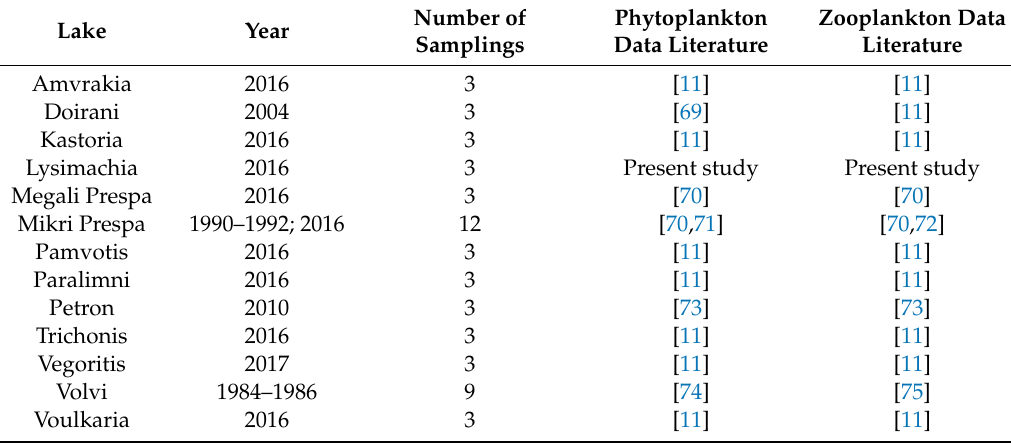
Table A1. Year and number of samplings for the studied 13 Greek lakes and the literature of phytoplankton and zooplankton